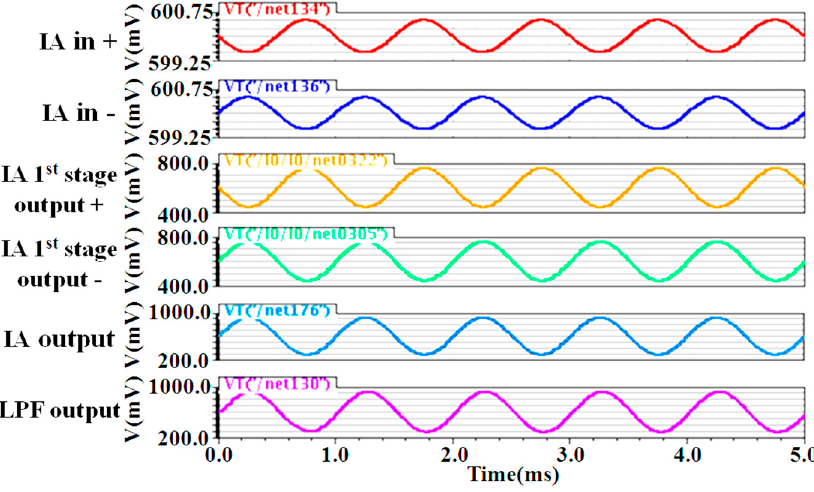
Figure 7. Transient simulation of the chopper IA.